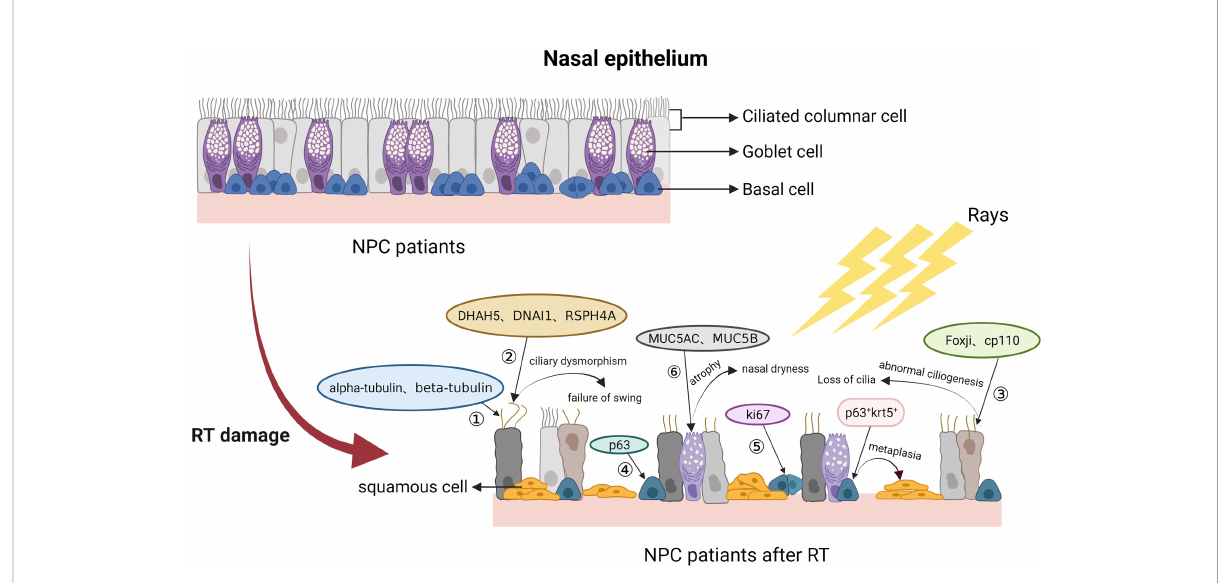
FIGURE 4 NPC patients after RT. After RT, nasal ciliated columnar cells of NPC patients gradually decrease in number and lose ciliary motility, goblet cells decrease in number or abnormally proliferate, and basal cells decrease in number or give way to squamous metaplasia. ① Biomarkers of ciliated columnar cells; ② Biomarkers of basal microtubule assemblies; ③ Biomarkers associated with ciliogenesis; ④ Biomarkers of basal cells; ⑤ Biomarkers of cell